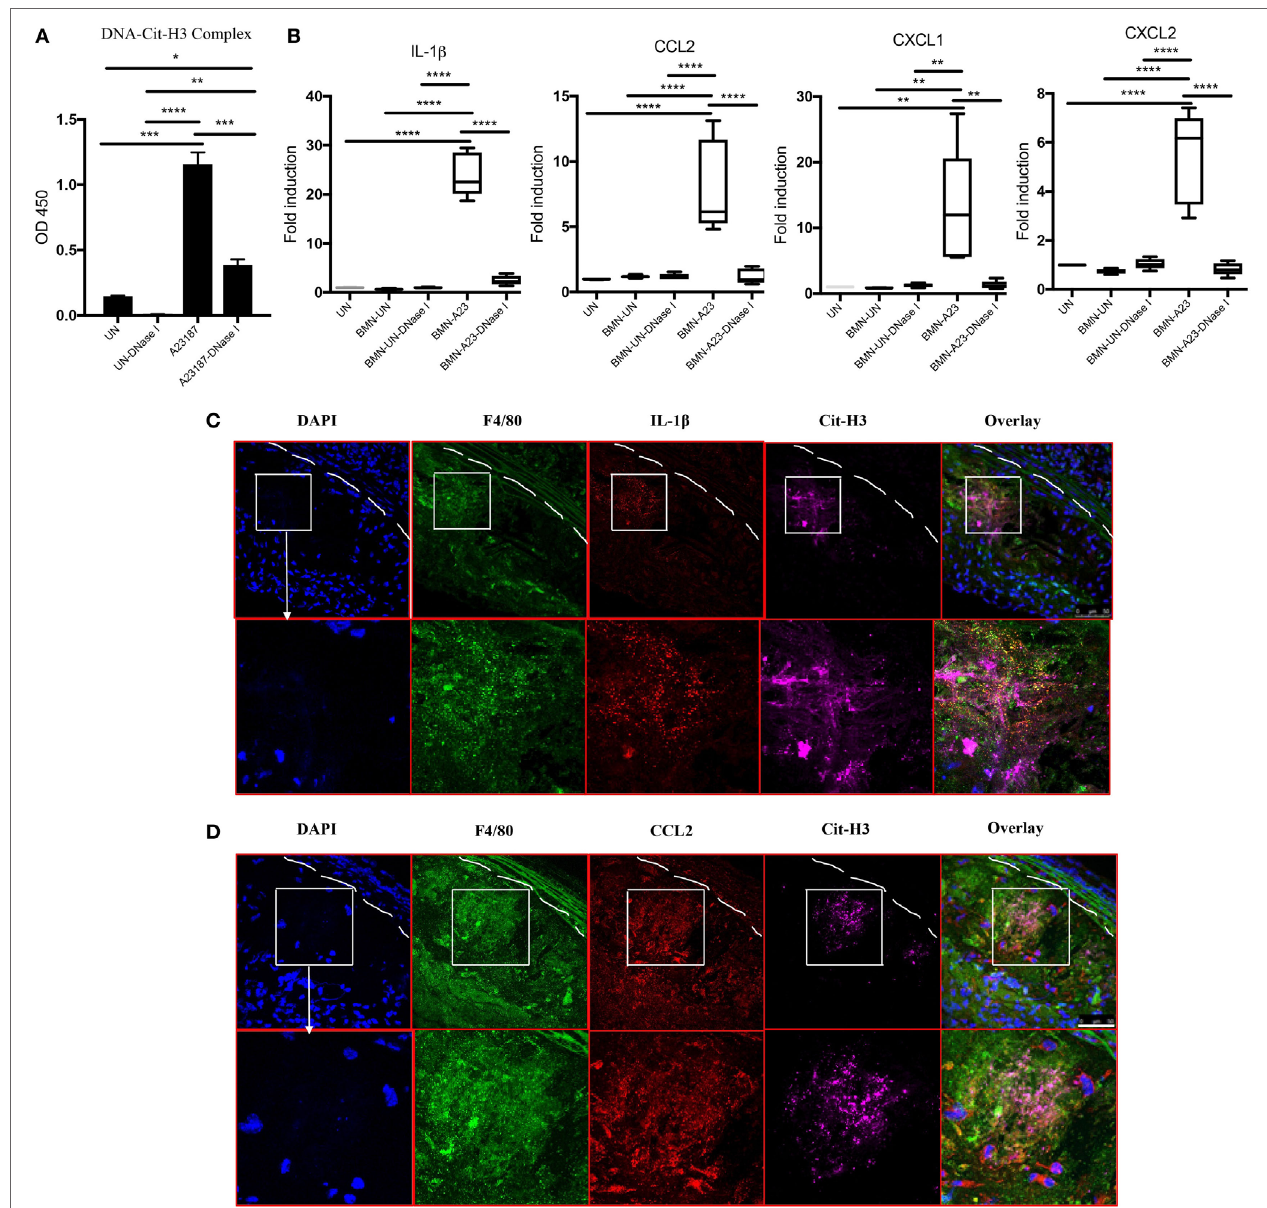
FigUre 6 | Neutrophil extracellular traps (NETs) present in atherosclerotic lesions stimulate inflammatory responses in arterial macrophages. (a) Bone marrow (BM)-derived neutrophils were stimulated in the absence (UN) or presence (A23187) of A23187 for 4 h. Half the UN-NETs or A23187-NETs were digested by deoxyribonuclease (DNase) I. NETs were quantified by measuring Cit-H3-DNA complexes on ELISA. (B) BM-derived macrophages were stimulated with UN-NETs (BMN-UN), UN-NETs treated with DNase I (BMN-UN-DNase I), A23187-NETs (BMN-A23), or A23187-NETs treated with DNase I (BMN-A23-DNase I) for 4 h. Gene expression levels of IL-1 β , CCL2, CXCL1, and CXCL2 were determined. mRNA levels were normalized to GAPDH and expressed relative to levels measured in one of the BMN-UN conditions (c) . WT and peptidylarginine deiminase 4 (PAD4) KO mice were fed high-fat chow (HFC) for 10 weeks, and aortic root sections were stained for indicated markers and observed by confocal immunofluorescence microscopy. Lower panel represents enlarged area of the white squares in upper panels. Blue: DAPI, green: F4/80, red: IL-1 β , and magenta: Cit-H3. Data are representative of four mice in two independent experiments. (D) WT and PAD4 KO mice were fed HFC for 10 weeks, and aortic root sections were stained for indicated markers and observed by confocal immunofluorescence microscopy. Lower panel represents enlarged area of the white squares in upper panels. Blue: DAPI, green: F4/80, red: CCL2, and magenta: Cit-H3. Data are representative of four mice in two independent experiments. * p < 0.05, ** p < 0.01, *** p < 0.001, **** p <